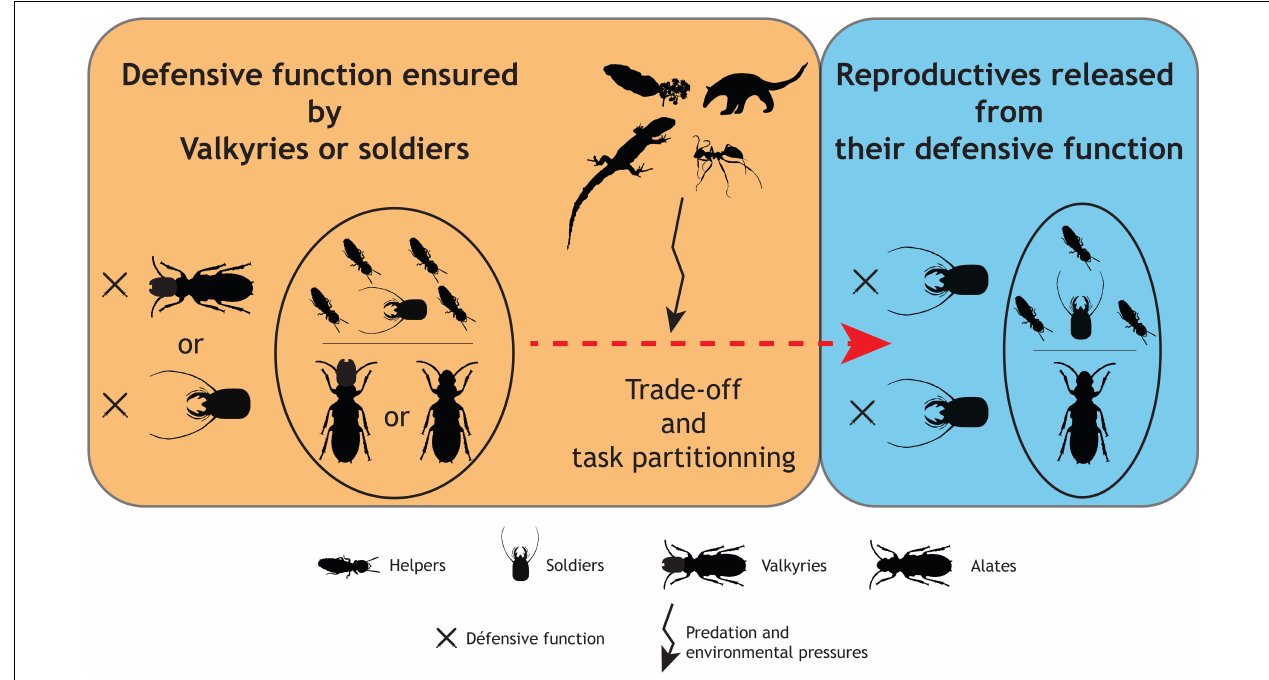
FIGURE 3 | Hypothesis on the evolution of defensive and reproductive functions in termite societies: insight from the Valkyries (silhouettes from or modified from http://phylopic.org/). Reproductive functions are assumed to be initially performed by Valkyries or “classic” alates when soldiers may have been present or not in the colony or not (orange panel). Later, as a result of predation and environmental pressures, and due to their putative high cost, Valkyries would have been counter-selected, resulting in a better task partitioning (blue panel).